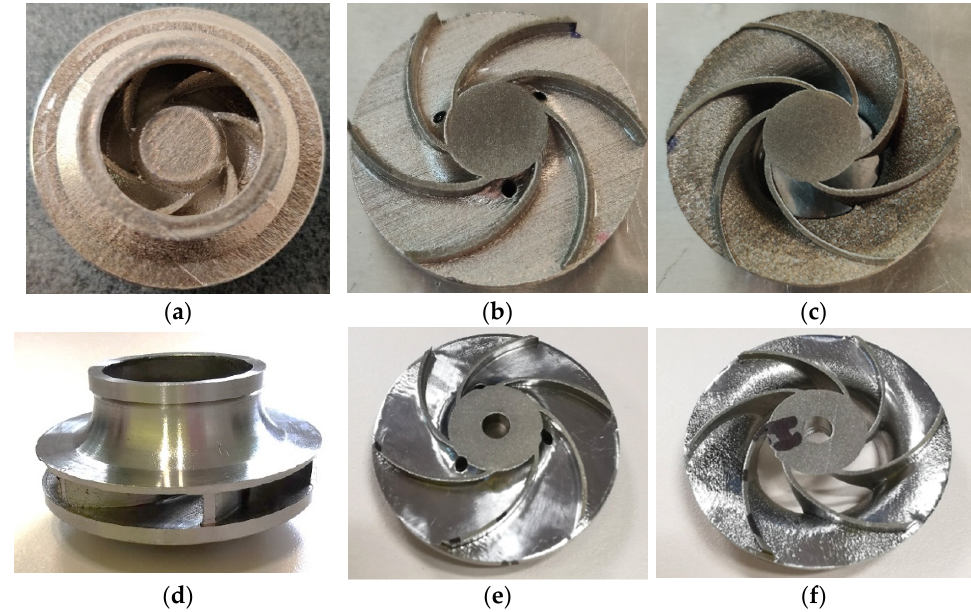
Figure 12. Post-processed (turned) closed impeller: ( a ) as-printed closed impeller; ( b ) as-printed disc half; ( c ) As-printed shroud half; ( d ) finished closed impeller; ( e ) finished disc half; ( f ) finished shroud half.